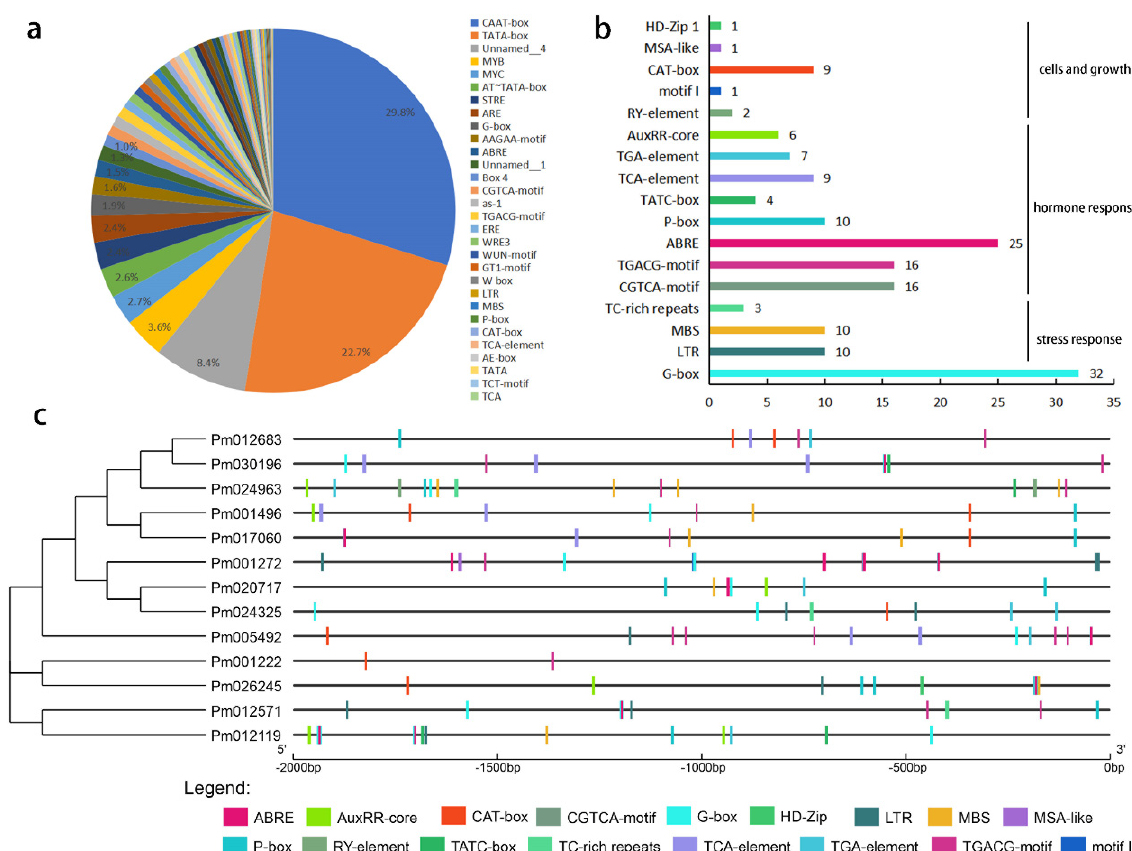
Figure 7. Cis − elements analysis of PmHDAC gene promoters located on the 2 kb sequences. ( a ) The proportion of all cis − elements predicted in the promoters of PmHDACs using PlantCARE website. ( b ) Numbers of the cis − elements involved in light responsiveness, stresses responsiveness, hormone responsiveness and cells and tissues development ( c ) The distribution of the main 17 cis − elements in ( b ) in PmHDAC gene promoters.